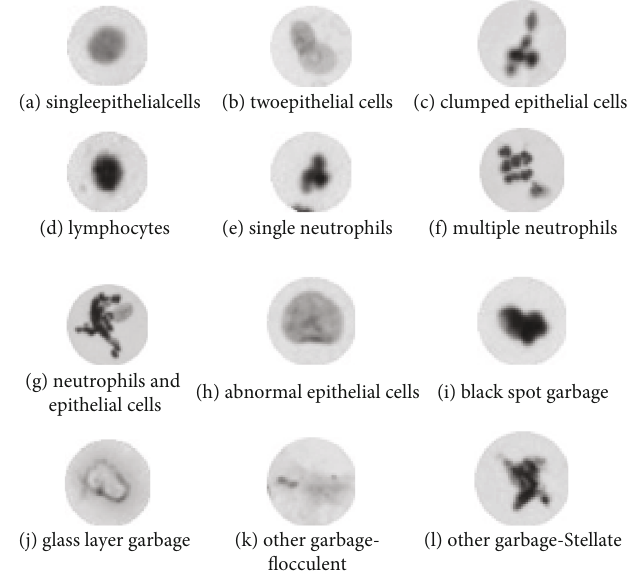
Figure 4: Part of typical data. Table 1: Experimental data situation of each group.